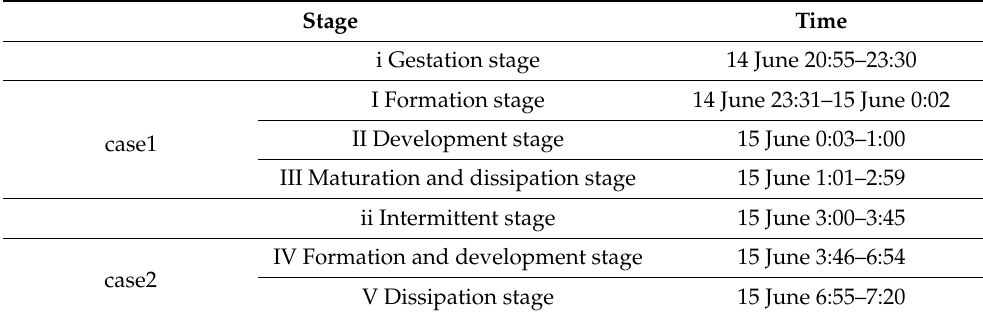
Table 3. Subdivide the stage of sea fog from 20:55 on 14 June to 7:20 on 15